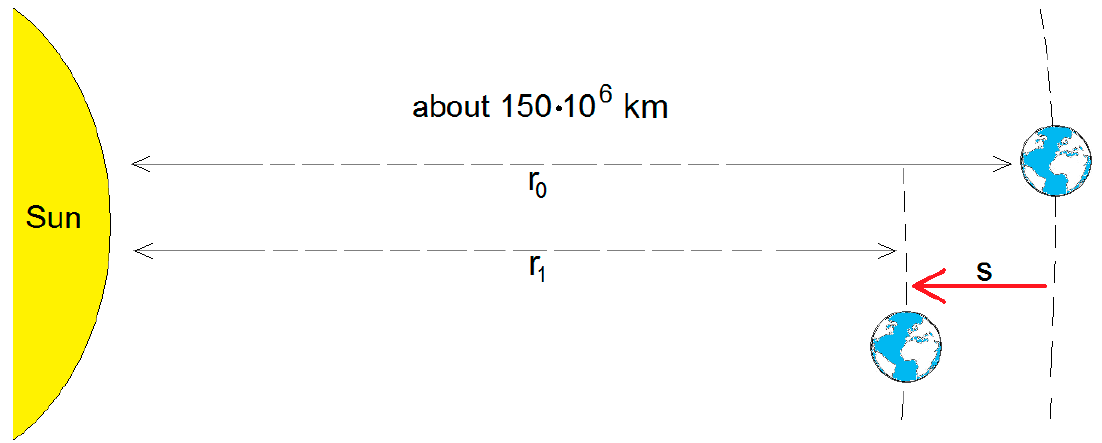
Figure 8. Global heat emission causes the seeming energetical effect as if the Earth was a little closer to the Sun. the